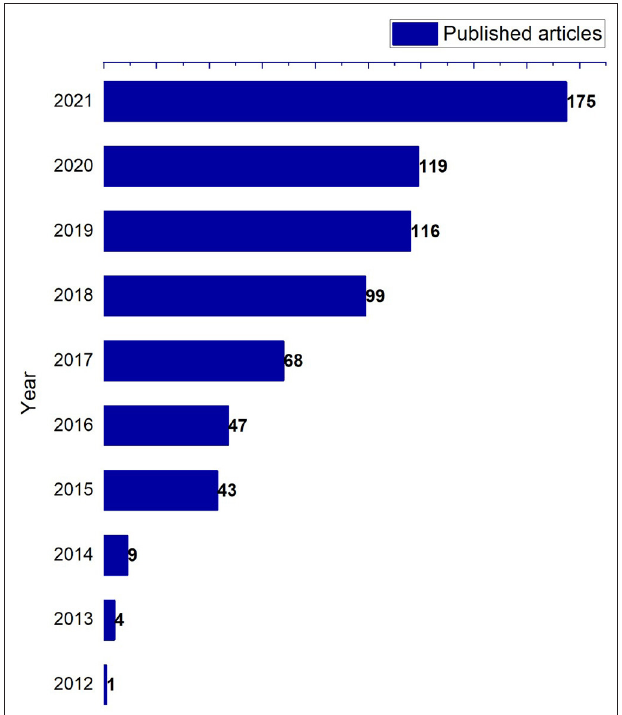
FIGURE 1 | Global number of scientific publications per year on water-energy-food nexus 2012–2021 from Scopus.